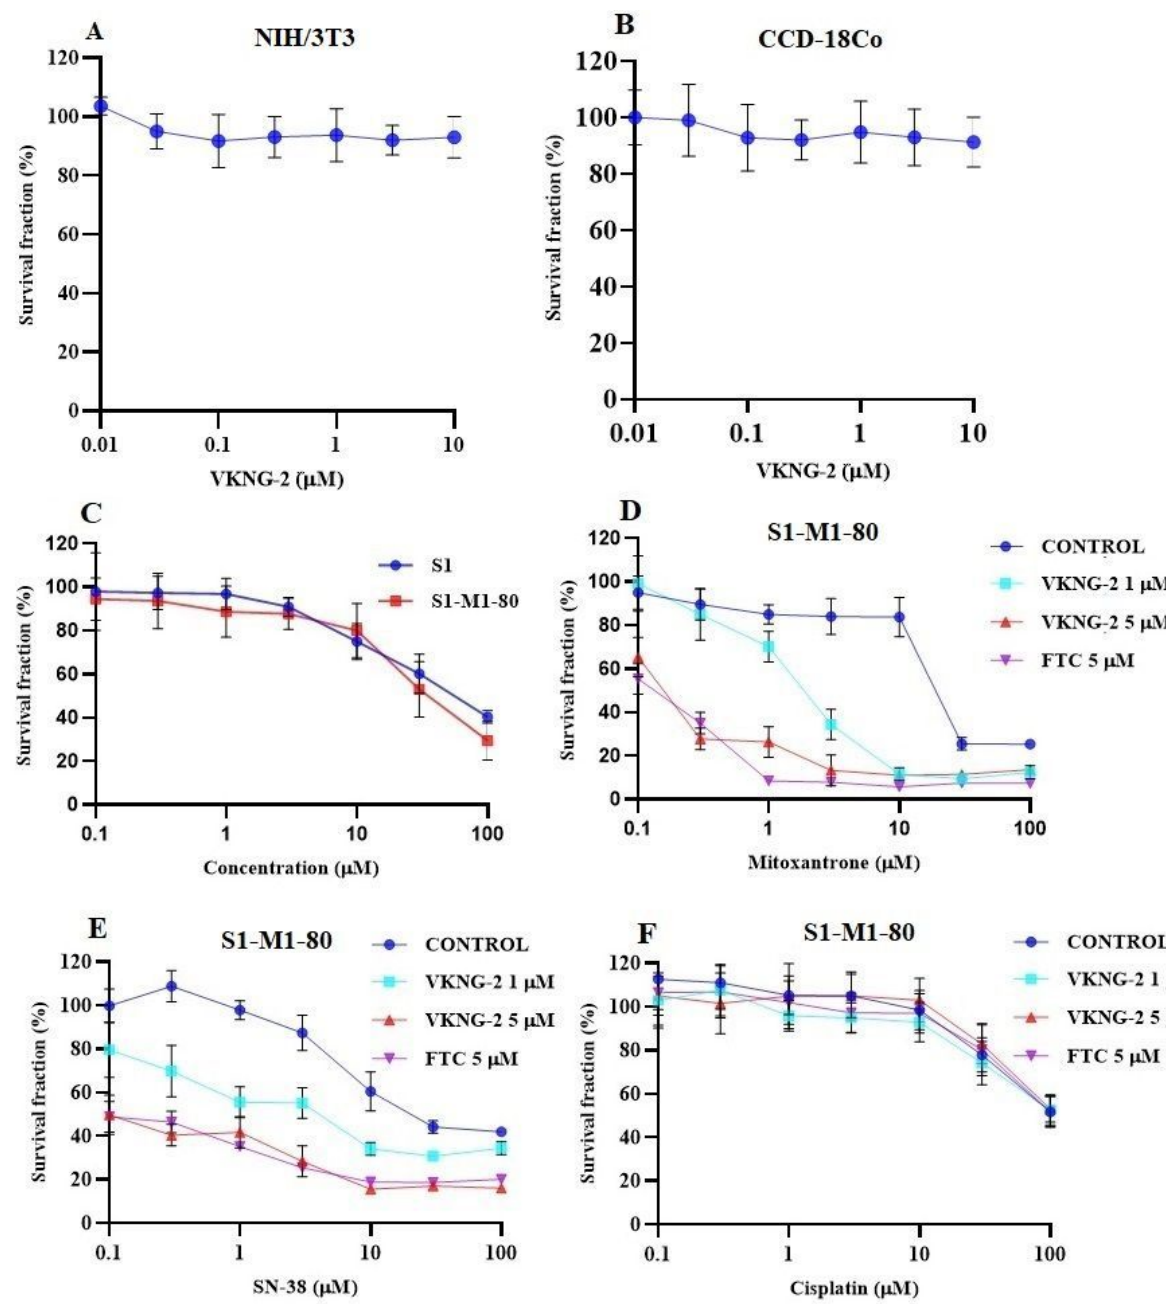
Figure 1. The effect of VKNG-2 in transformed mouse fibroblast (NIH/3T3) and human colon fibroblast (CCD-18Co) cell lines ( A , B ). The effect of VKNG-2 in S1 parental and ABCG2-overexpressing S1-M1-80 colon cancer cells ( C ). The survival fraction (%) was determined following incubation with 5 µ M of VKNG-2 for 72 h in S1 (blue) and S1-M1-80 (red) cell lines and IC 50 values of mitoxantrone ( D ), SN-38 ( E ), and cisplatin ( F ) in parental S1 and drug-selected ABCG2 overexpressing S1-M1-80 colon cancer cells with or without VKNG-2. The points with error bars represent the mean ± SD of independent determinations in triplicate. The figures are representative of three independent